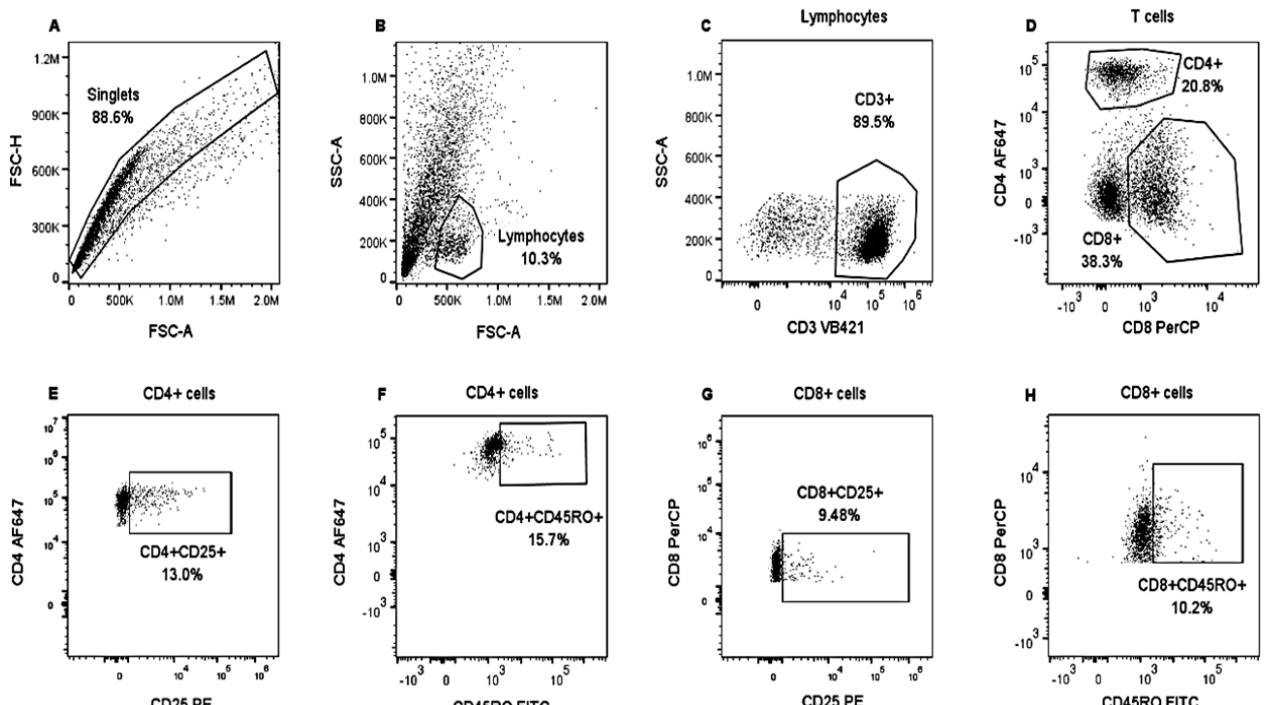
Figure 2. Analysis strategy to identify lymphocyte populations in bovine PBMCs. PBMCs from heifers positively and negatively tested for tuberculin were stimulated with CFPE and cultivated for nine days. An unstimulated control was also included. Then, PBMCs were stained with Panel 2. Singlets were gated on FSC-H and FSC-A ( A ). Lymphocytes were identified from the singlets based on SSC and FSC properties ( B ). T lymphocytes were identified by applying SSC and evaluating CD3 + expression ( C ); these were separated into CD8 + and CD4 + T cells ( D ). CD25 + ( E , G ) and CD45RO + ( F , H ) expression were analyzed in both T cell populations. PBSCs from a tuberculin- negative heifer and stimulated with